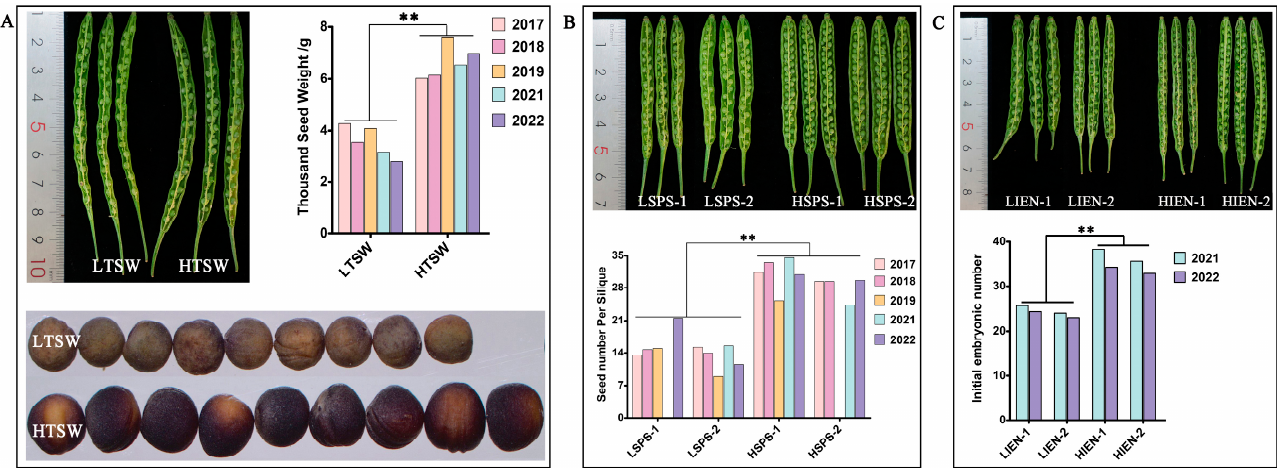
Figure 8. Phenotype and statistical analysis of the materials with differences in thousand-seed weight (TSW; A ), seed number per silique (SPS; B ), and initial embryonic number (IEN; C ) in B. napus . LHI and LTSW and HTSW indicate high- and low-TSW materials; LSPS and HSPS indicate high- and low-SPS materials; LIEN and HIEN indicate high- and low-IEN materials; The p value were performed with one-way ANOVA and ** represent significant difference at p _Value < 0.01. Table 4. Phenotypic analysis of yield-related extremely materials during multiple years of field tests.